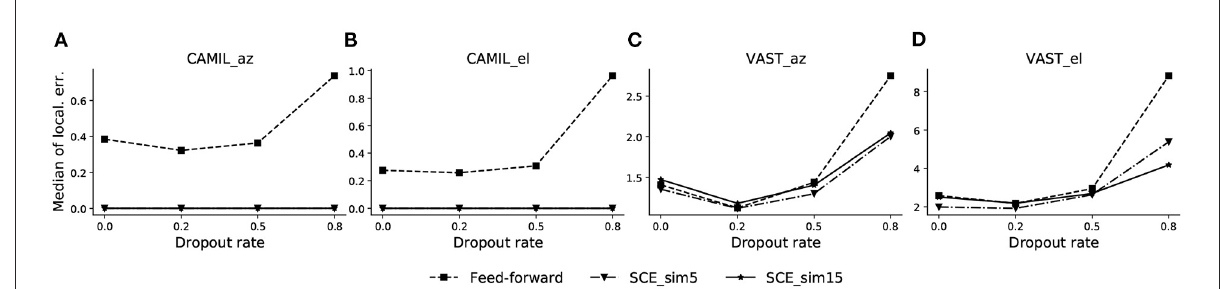
FIGURE2 Validation performance across different dropout rates for CAMIL validation set (A,B) , and VAST validation set (C,D) . The dropout rate is tested for both the proposed SCE with similarity threshold angle ǫ u equal to 5 and 15 (denoted by_sim5 and _sim15, respectively), and the baseline feed-forward method. Both methods are tested for source azimuth (denoted by _az) and elevation (denoted by _el) estimation. Localization errors are in